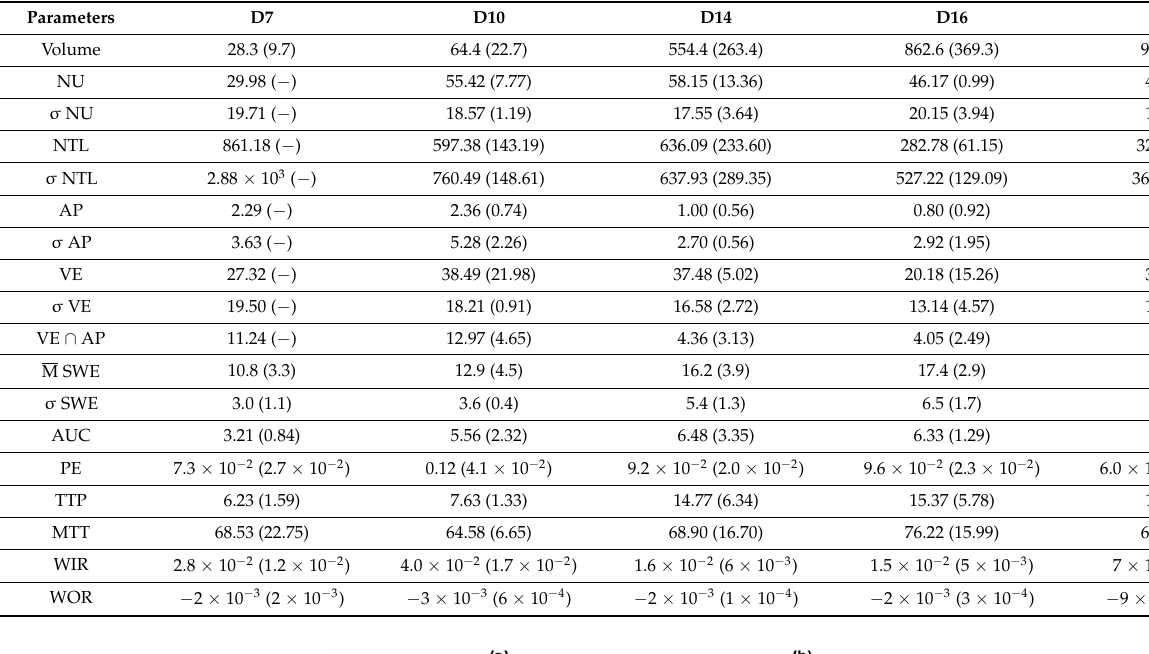
Table 1. Evolution of the median (interquartile range) of the following parameters over time: tumor volume (mm 3 ), histological parameters (percent area occupied by nuclei (NU), the number of T Lymphocytes per mm 2 (NTL), the percent area of apoptosis (AP), and percent area of vascular endothelium (VE), and their spatial standard deviation σ , and the co-localization of a high VE and AP (VE ∩ AP)), the SWE parameters (mean M and standard deviation σ in kPa), and CEUS parameters (Area Under the Curve (AUC), Peak Enhancement (PE), Time to Peak (TTP), Mean Transit Time (MTT), Wash-In Rate (WIR), and Wash-Out Rate (WOR)).